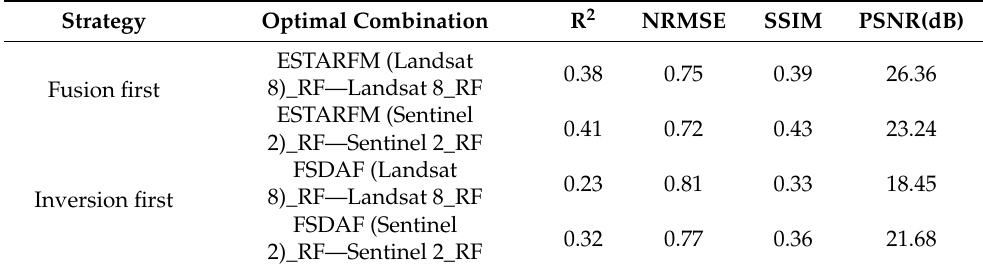
Table 6. Consistency evaluation of SPM inversion map of fusion image and original